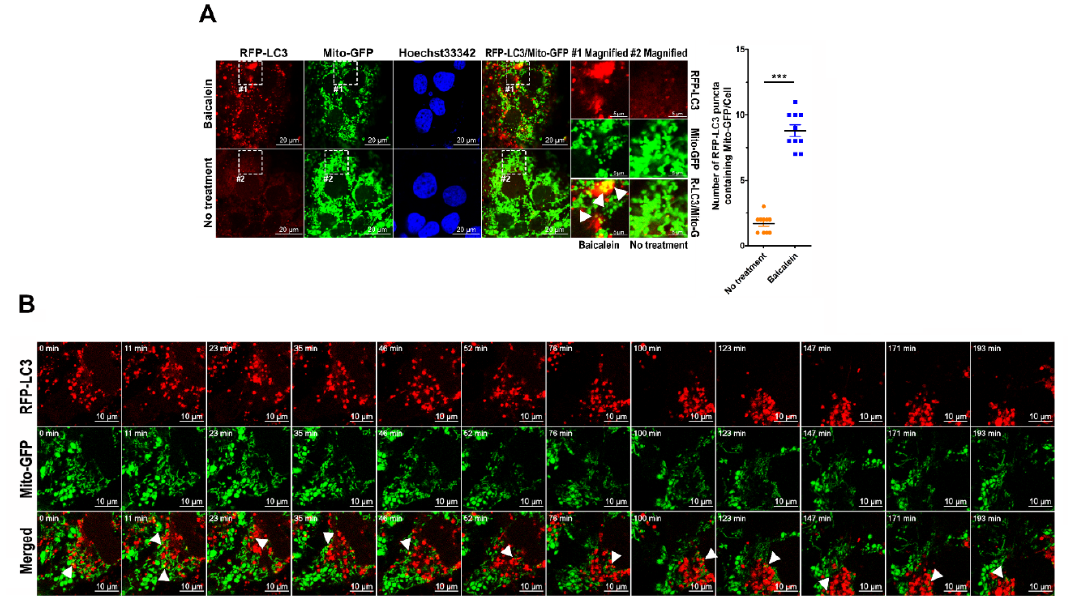
Figure 5. Dynamics of mitochondrial sequestration in baicalein-induced autophagy: ( A ) Huh7 cells stably coexpressing RFP-LC3 and Mito-GFP (Huh7/RFP-LC3/Mito-GFP) were established by lenti- viral gene delivery as described in “Materials and Methods”. Huh7/RFP-LC3/Mito-GFP cells were treated with or without 0.5 mM baicalein for four hours, fixed and stained with Hoechst 33342, and analyzed by confocal microscopy. The degree of colocalization between Mito-GFP-labeled mito- chondria and RFP-LC3 puncta was quantified. The data represent the means ± SEM ( n = 10, *** p < 0.001). Magnified field-1 and magnified field-2 show the enlarged images of the areas in white dashed boxes 1 and 2 in the images of baicalein-treated and untreated cells, respectively. The white arrowheads in magnified field-1 indicate the colocalized signal. ( B ) Selected live imaging frames showing 0.5 mM baicalein-treated Huh7/RFP-LC3/Mito-GFP cells. The engulfed Mito-GFP shown within RFP-LC3 puncta is indicated by white arrowheads. All frames in the sequence showing this engulfment are presented in Supplemental Video S4. Furthermore, we used CLEM to analyze mitochondrial engulfment at the ultrastruc- tural level during baicalein-induced autophagy. In baicalein-treated RFP-LC3/Mito-GFP cells, confocal microscopy images taken at different Z-positions (Figure 6A) were assem- bled to reconstitute the 3-D deconvoluted structure shown in Figure 6B. In this 3-D recon- stituted structure, a perinuclear area with RFP-LC3 puncta encompassing Mito-GFP was detected (Figure 6B, white dashed box). After aligning the confocal microscopy and EM images, the CLEM results shown in Figure 6C revealed that RFP-LC3 puncta overlapping the Mito-GFP area (IF image in right middle panel) contained autophagic vacuoles (EM image in right bottom panel) in which numerous degradative mitochondria had been en- gulfed (arrowheads in the EM image), directly indicating that baicalein-induced autoph- agy participated in the elimination of mitochondria. Taken together, these results indi- cated that baicalein activated autophagy to promote mitochondrial turnover.